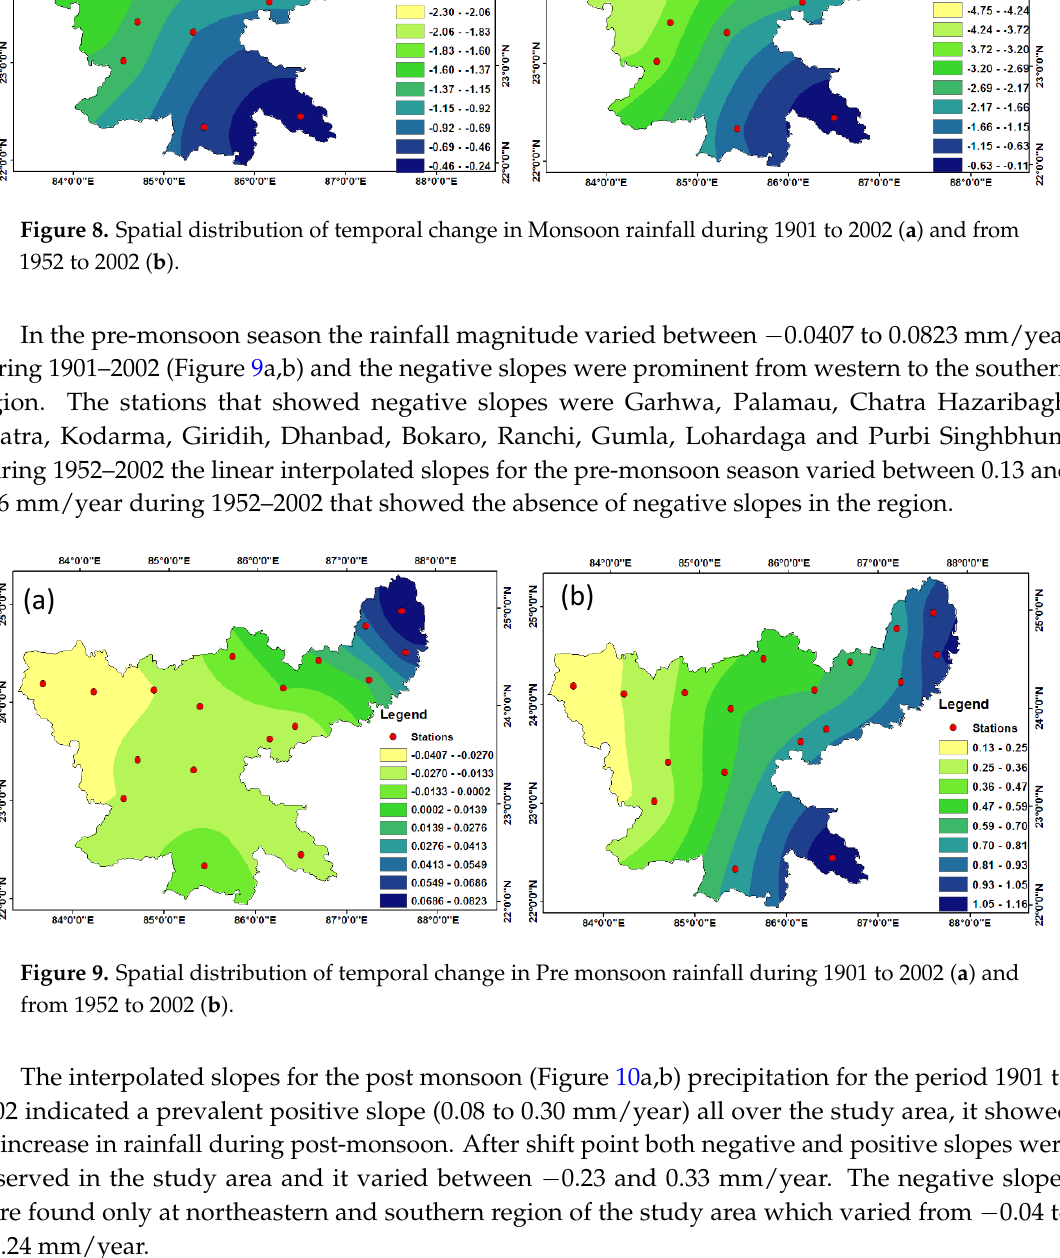
Figure 7. Spatial distribution of temporal change in Annual rainfall during 1901 to 2002 ( a ) and from 1952 to 2002 ( b ).